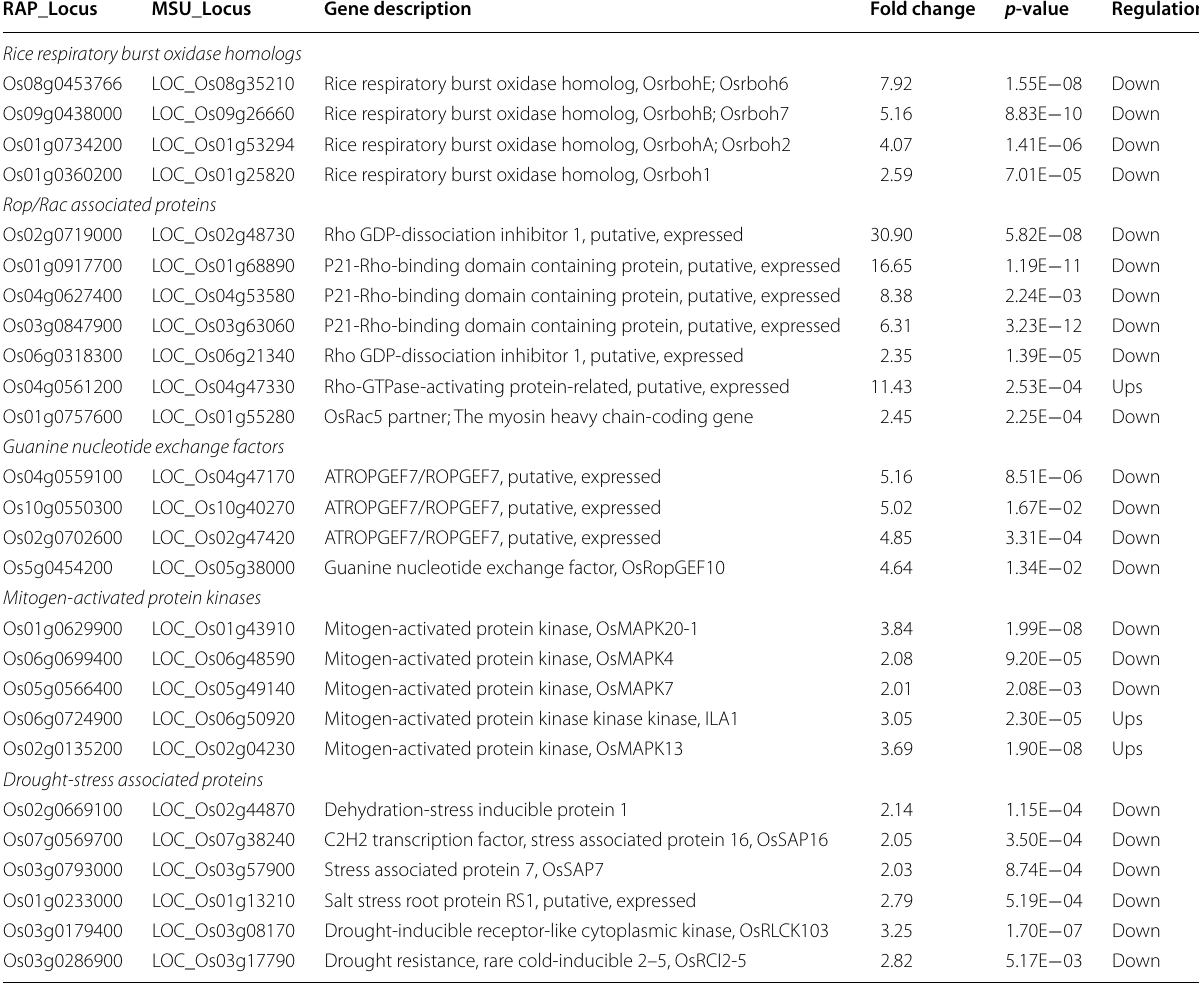
The expression levels of the genes were detected by RNA-seq